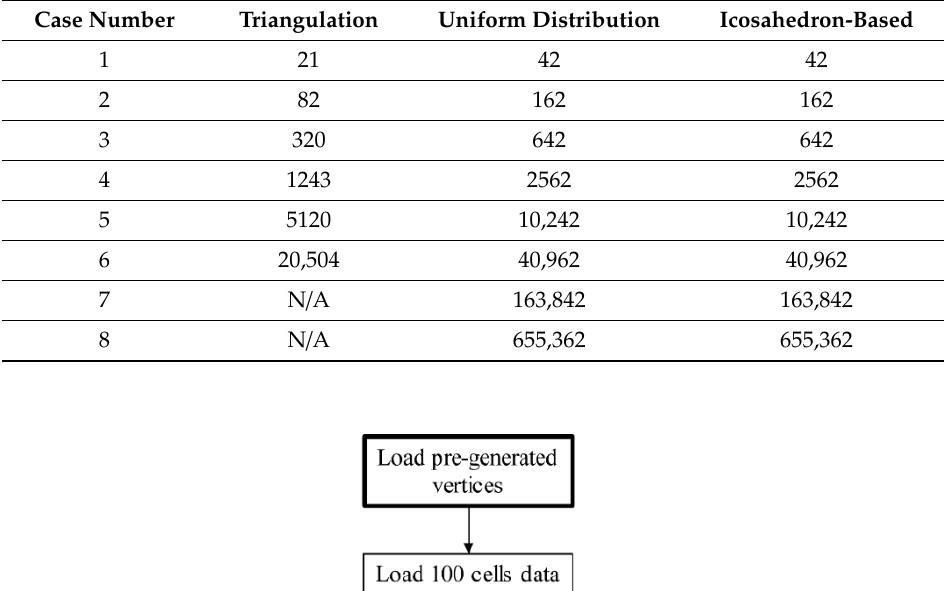
Table 1. The number of vertices.